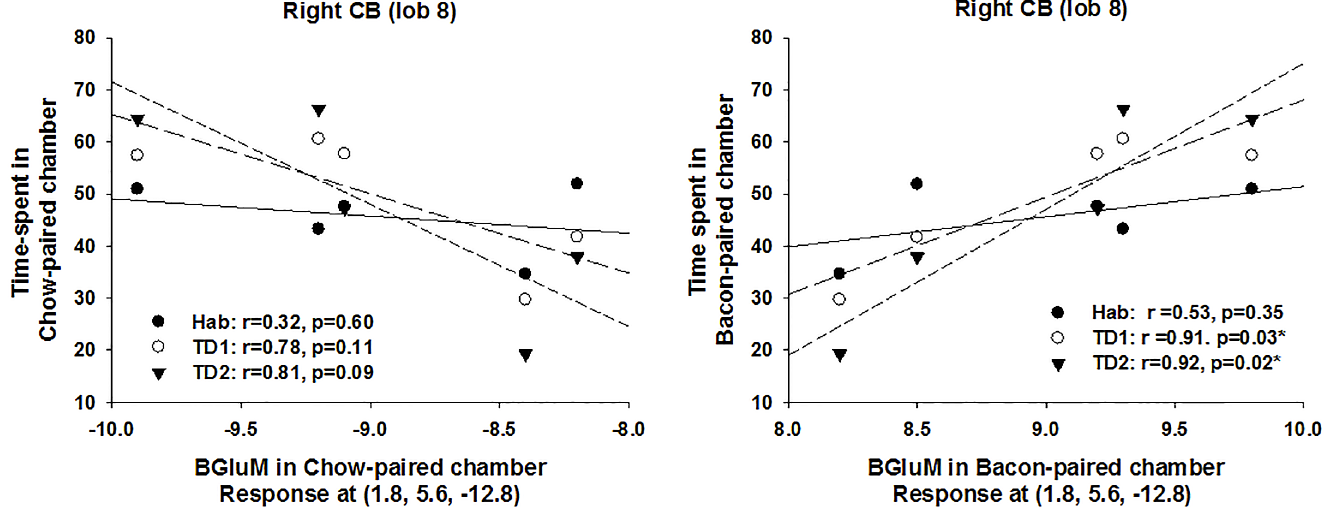
Fig 8. Correlation plots between CPP preference for Chow or Bacon and BGluM during Habituation (Hab), Test Day 1 (TD1) or